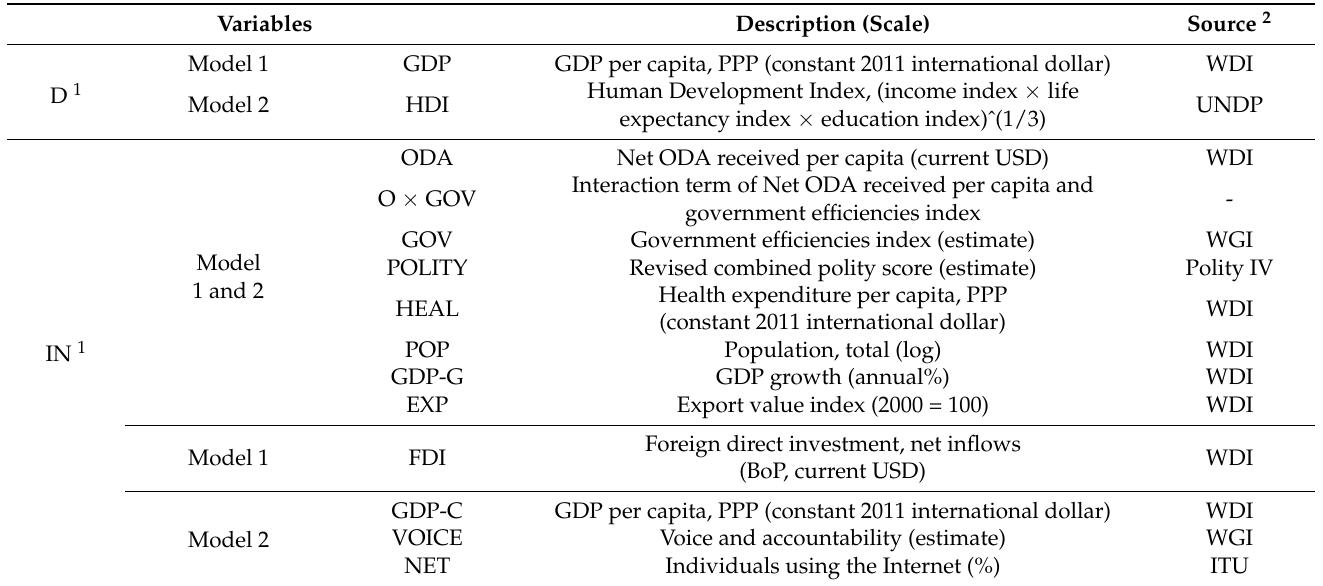
Figure 2. Distribution of target countries (observations). Table 1. Variables for Regression Models 1 and 2.